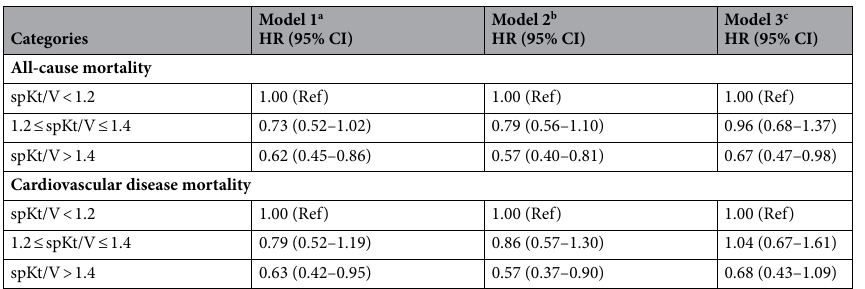
Table 2. Hazard ratios (95% CI) for the association between dialysis dose and all-cause and cardiovascular disease mortality. CI confidence interval, HR hazards ratio, Ref , reference. a Model 1: Crude model. b Model 2: Adjusted for age, gender and duration of dialysis. c Model 3: Adjusted for age, gender, duration of dialysis, heart failure, hemoglobin, albumin, creatinine, total cholesterol and primary disease.